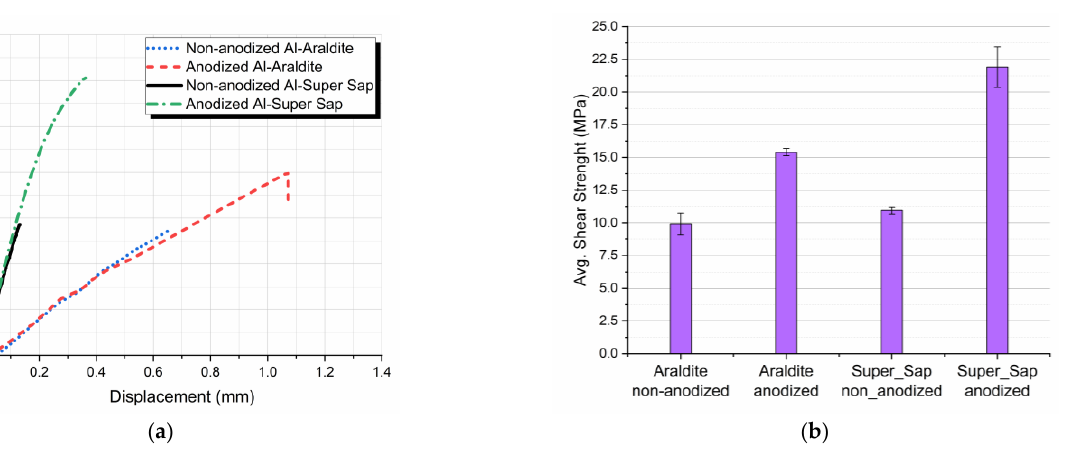
Figure 7. Effect of aluminum adherends anodization on the aluminum single-lap joints bonded with Araldite and Super Sap adhesive tensile-shear behavior; ( a ) load-displacement curves, ( b ) bar diagram for the joints’ average shear strength values. Table 3. Comparison of the average shear strength values for the different types of adhesive aluminum single-lap joints manufactured and